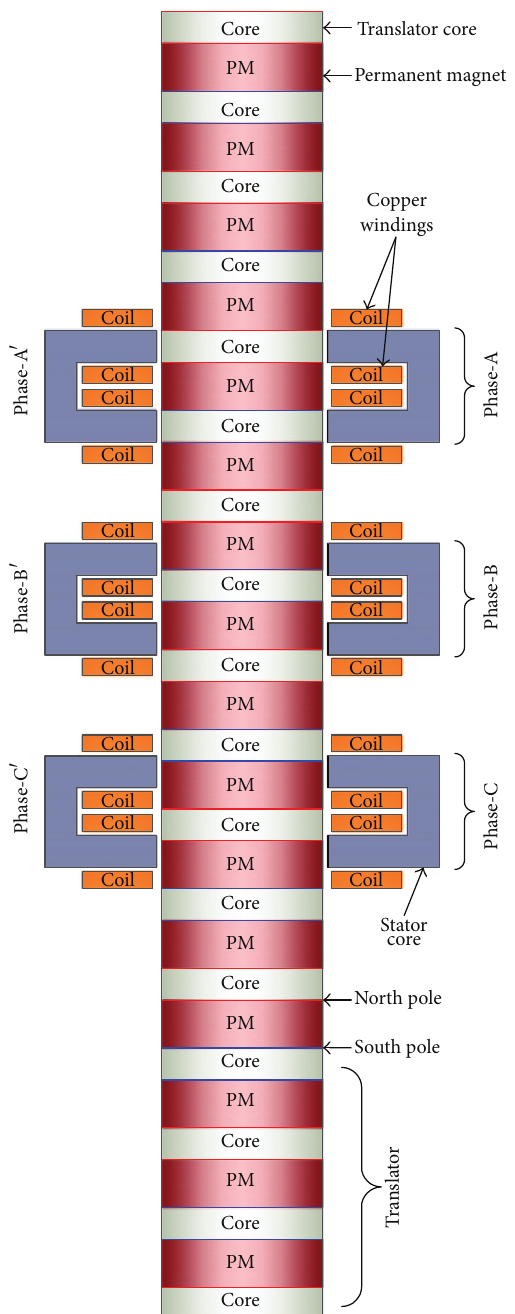
Figure 6: Construction of the